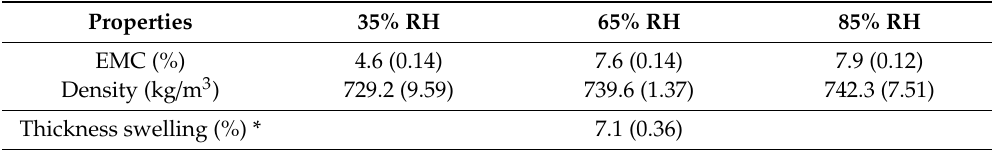
Table 2. Physical properties of Medite Tricoya ® MDF samples at di ff erent RH levels. Values in parenthesis are the standard